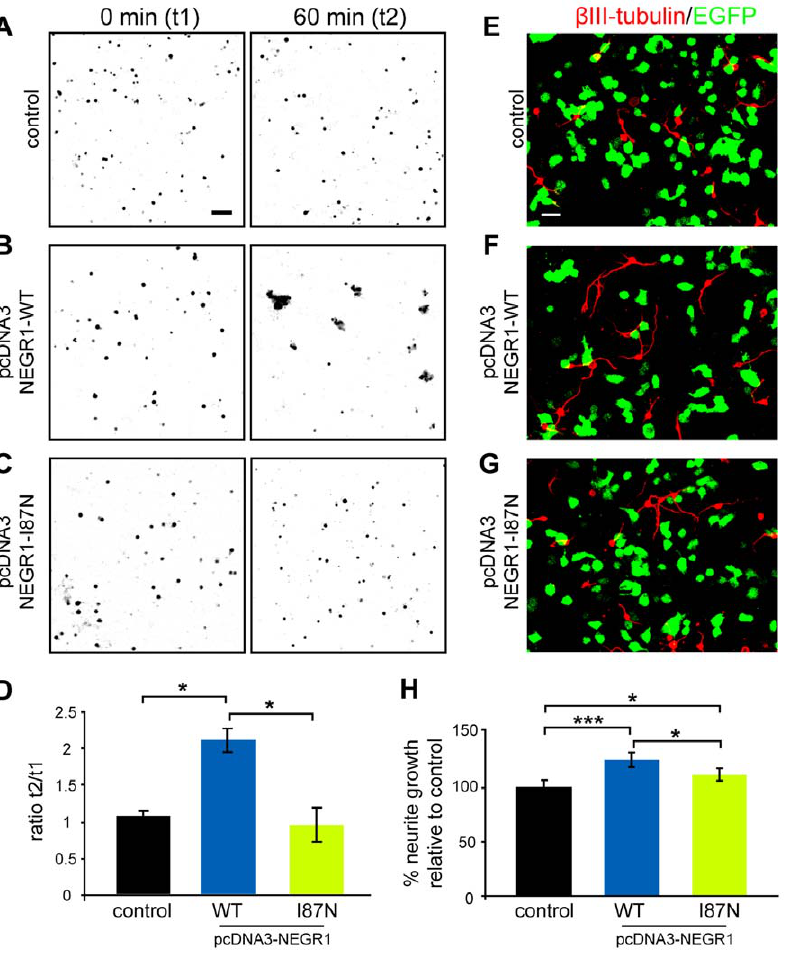
Figure 9. Negr1 -I87N is a loss-of-function mutation. A–C. NSC-34 cells expressing EGFP alone (control) or together with Negr1 -WT or Negr1 - I87N mutants at 0 min (t1) and following 60 min (t2) of cell aggregation. D. Histogram showing cell aggregation expressed as the ratio of 0 min (t1) and 60 min (t2) time points. EGFP + empty vector (control): 1.06 6 0.05; NEGR1-WT + EGFP: 2.11 6 0.2; EGFP + NEGR1-I87N: 0.93 6 0.2. Data represent means 6 sd calculated from three independent experiments. E–G. Confocal images showing hypothalamic neurons immunostained for the neuronal marker b III-tubulin (red) cultured together with transfected NSC-34 cells (green). NSC34 cells were transfected with (E) pEGFP together with an empty pcDNA-vector (control), (F) pEGFP + pcDNA3-NEGR1-WT and (G) EGFP + NEGR1-I87N. H. Mean neurite lengths of hypothalamic neurons relative to control (set to 100%). Error bars represent SEM from three independent experiments ( , 400 neurites per condition). Two-tailed Student’s test; * P , 0.05; ** P , 0.01; *** P , 0.001. Scale: 100 m m (A), 20 m m